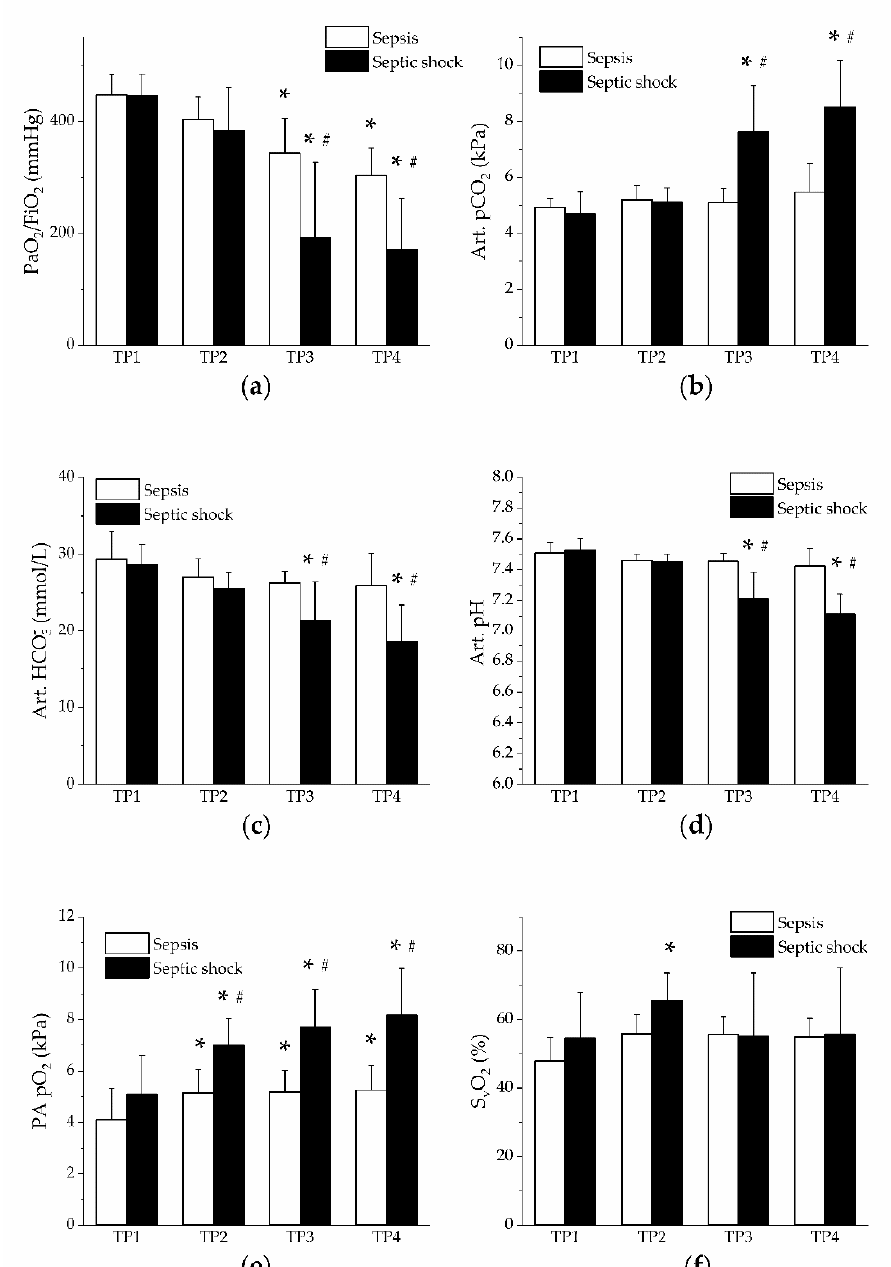
Figure 3. Respiratory gases and acid-base balance. Open columns, sepsis; filled columns, septic shock. *, p < 0.05 vs. baseline (TP1); #, p < 0.05 vs. sepsis. ( a ) PaO 2 /FiO 2 ratio in sepsis and septic shock; ( b ) arterial pCO 2 in sepsis and septic shock; ( c ) arterial bicarbonate in sepsis and septic shock; ( d ) arterial pH in sepsis and septic shock; ( e ) mixed venous (pulmonary artery, PA) pO 2 in sepsis and septic shock; ( f ) mixed venous (pulmonary artery) O 2 saturation (SvO 2 ) in sepsis and septic shock.